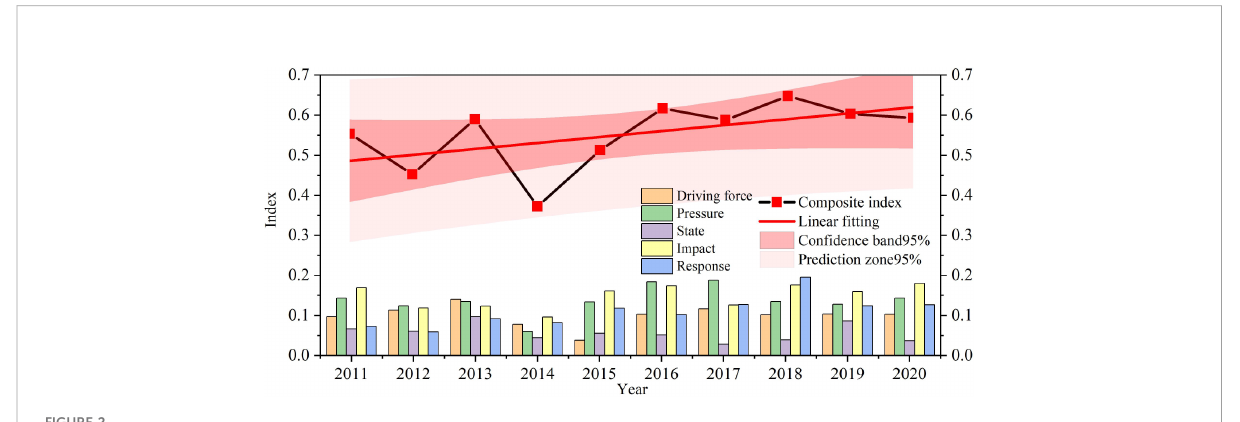
FIGURE 2 Evaluation results of the ecological security of the Qinzhou